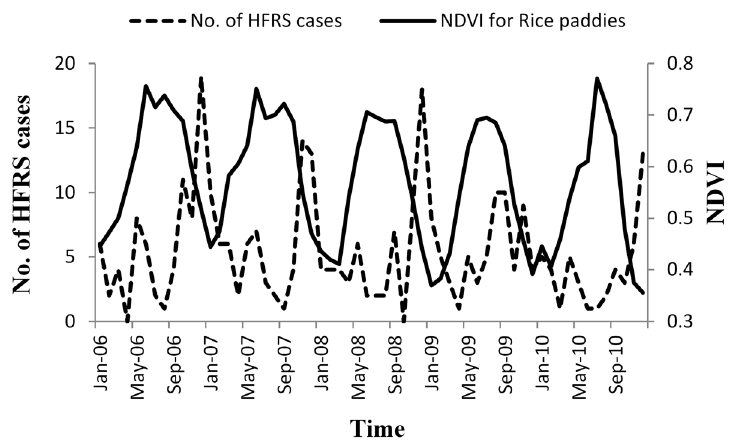
Figure 3. HFRS cases and normalized difference vegetation index (NDVI) for cultivated land.